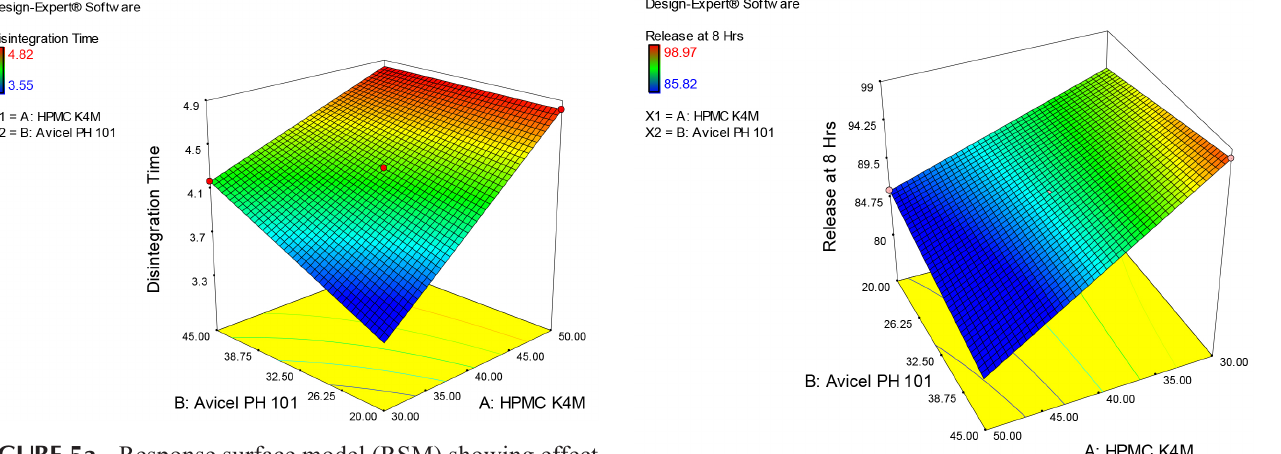
FIGURE 5a - Response surface model (RSM) showing effect of independent variables HPMC K4M and Avicel pH 101 on Disintegration time.